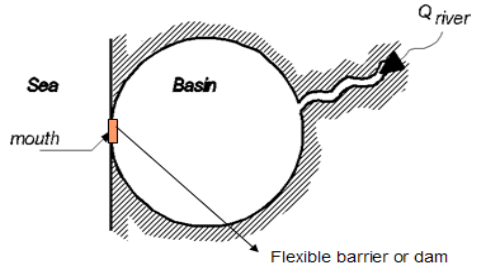
Figure A2. The conceptual model of the closable delta.